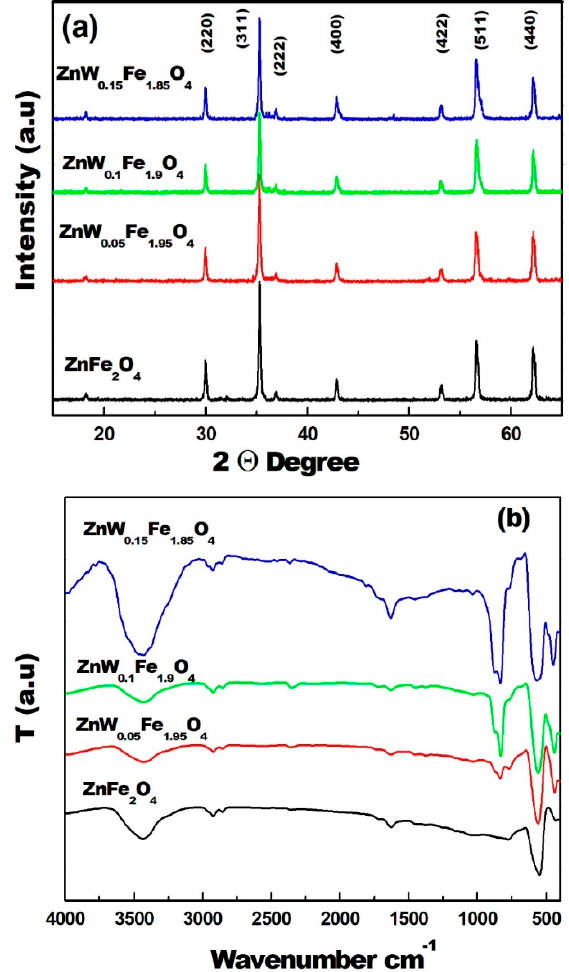
Figure 5. X-ray diffraction patterns ( a ) and FTIR ( b ) of ZnFe 2 O 4 , ZnW 0.05 Fe 1.95 O 4 , ZnW 0.1 Fe 1.90 O 4 , and ZnW 0.15 Fe 1.85 O 4 .